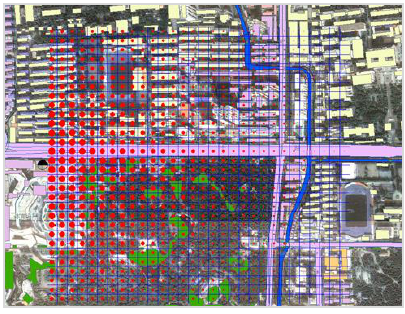
Figure 3 Simulation effect of toxic gas